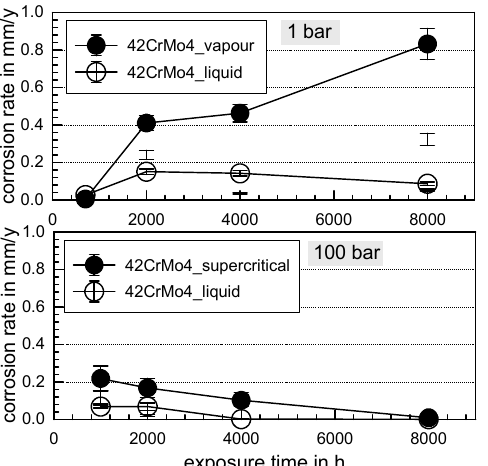
Figure 3. Comparison of corrosion rates of 42CrMo4 and X46Cr13 after 8000 h of exposure to aquifer brine water at 60 °C and ambient pressure, as well as at 100 bar.